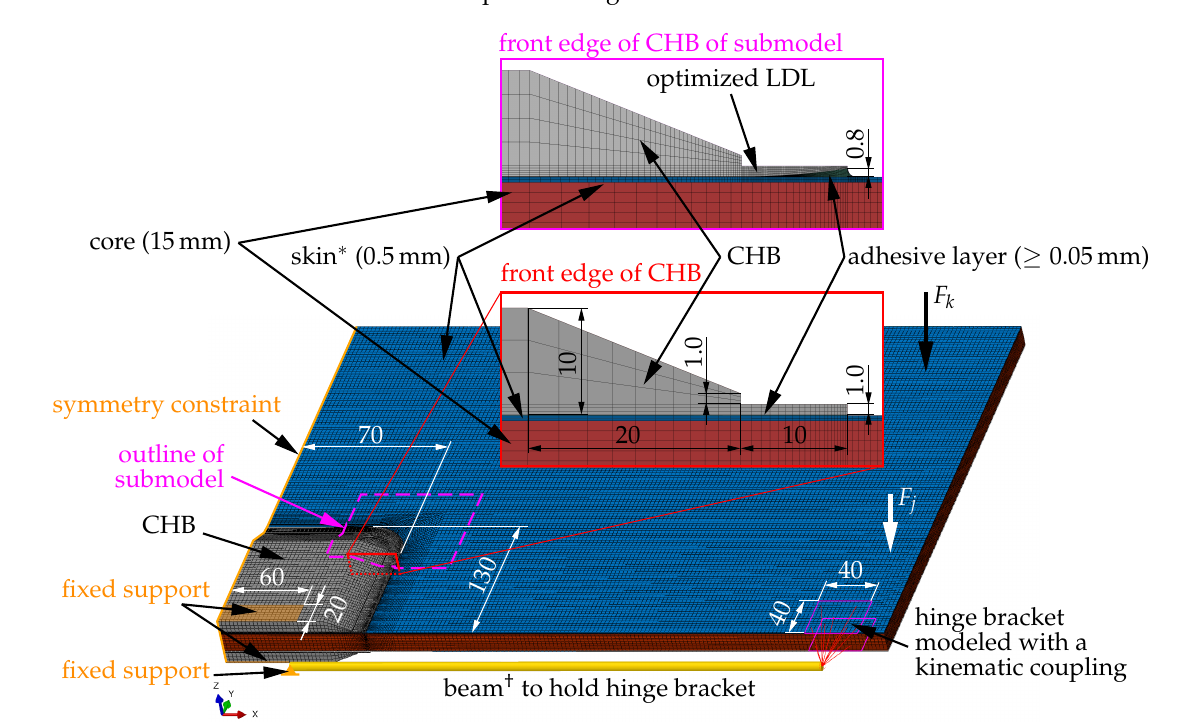
Figure 6. Detailed 3D FE model (all dimensions in millimeters), * shell thickness, and † beam cross-section rendered for display